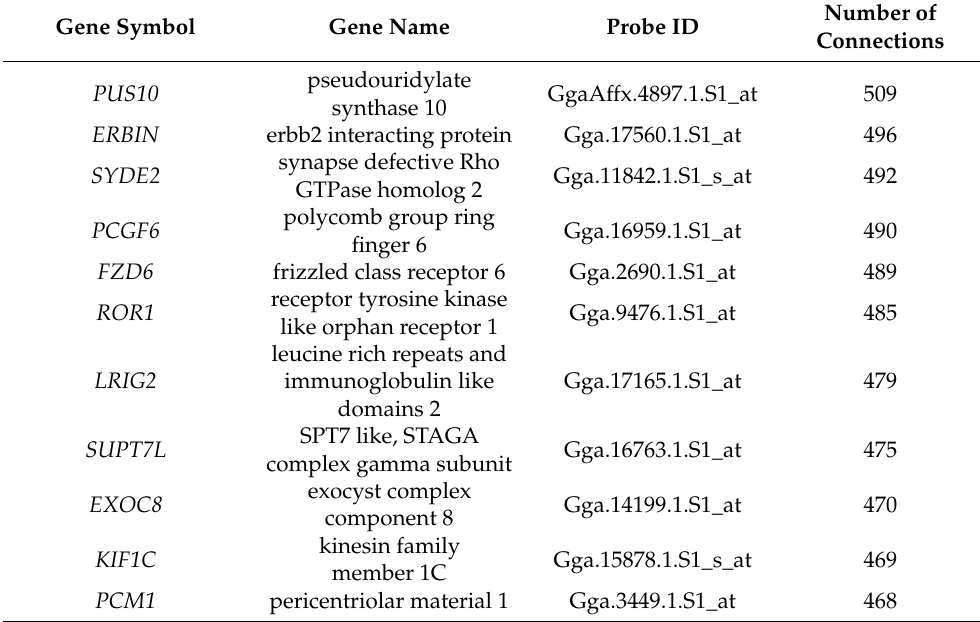
Table 5. Hub genes for all down-regulated